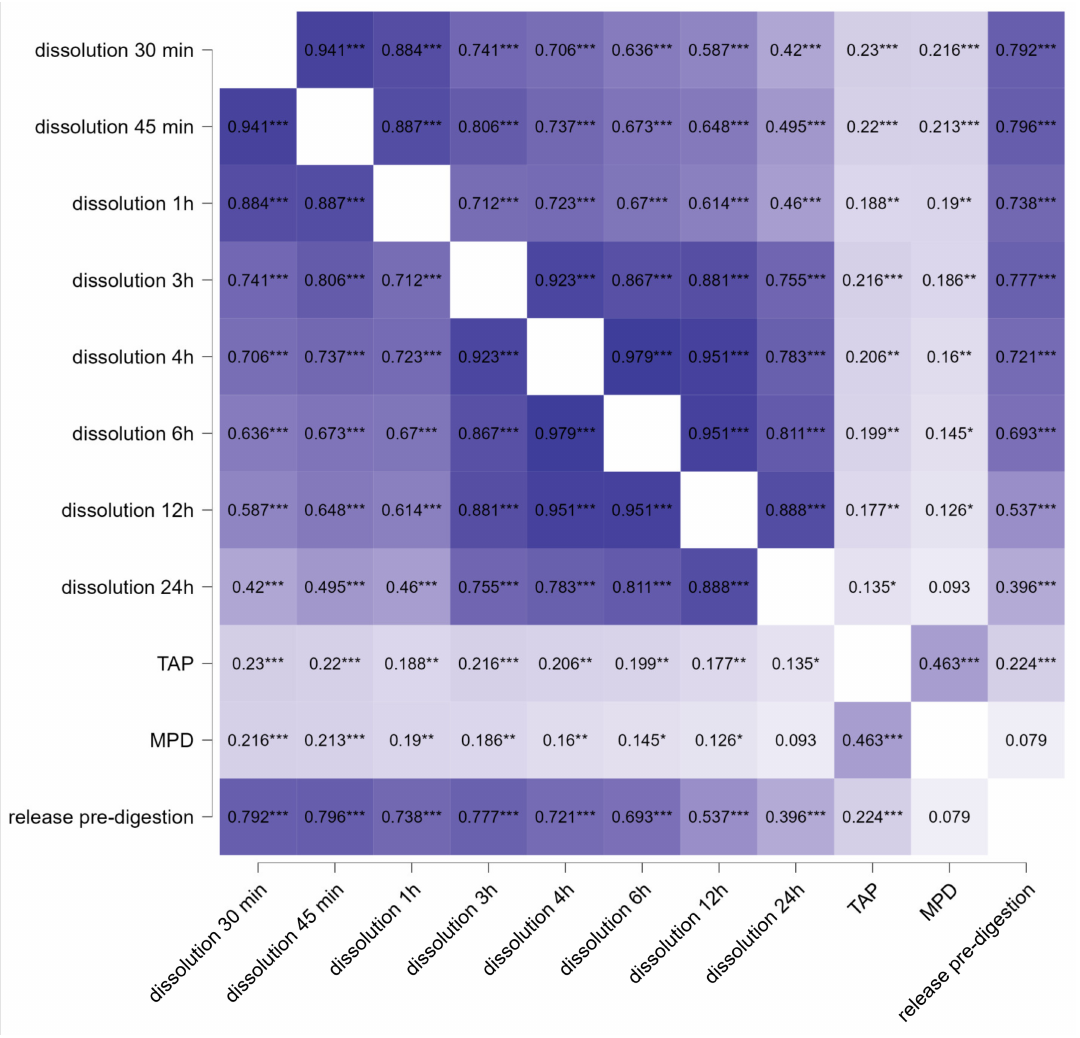
Figure 9. Heatmap of Spearman’s rank correlation coefficients ρ that assess the relationship between the in vitro dissolution data and the ex vivo permeation data for the physical mixture and the smartFilm tablets. * p < 0.05, ** p < 0.01, *** p <